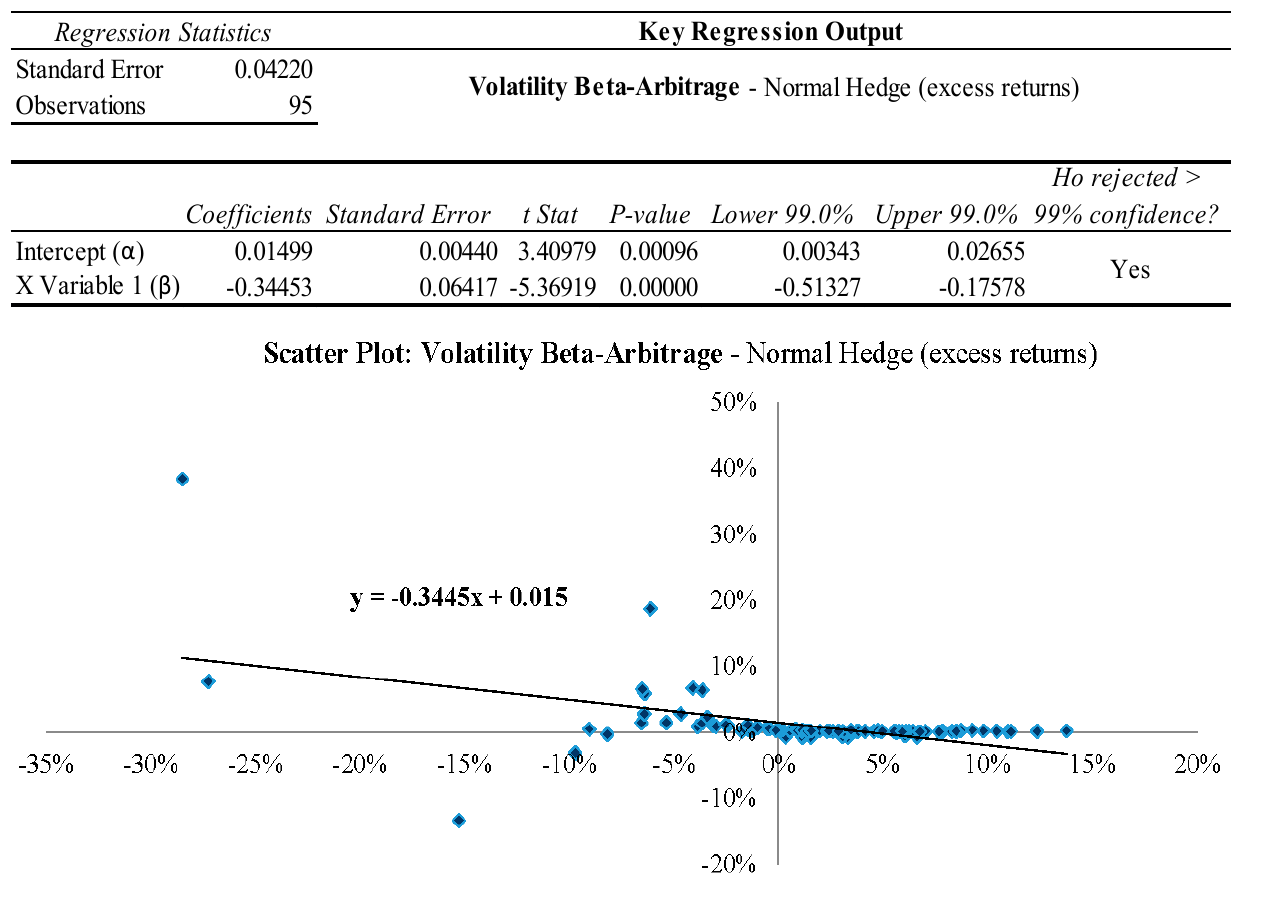
Figure A1. The above shows the visualized regression output as well as specific statistics for the normal hedge strategy, in the table. The S&P 500 excess return is on the x -axis, while the strategy is on the y -axis, exhibiting the positive returns described in the paper.